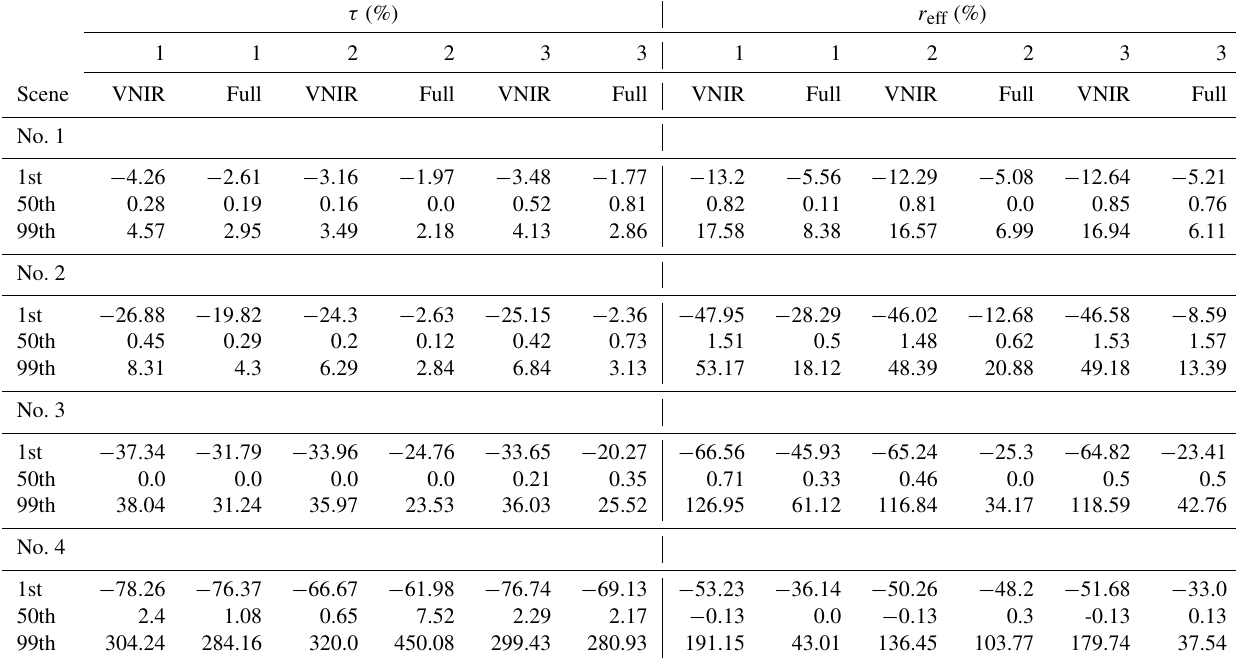
Table 2. Comparison of the cloud property retrieval results from downscaling experiments 1–3, which only account for the VNIR part, and the full downscaling experiments, which include adjustments to both VNIR and SWIR reflectances. The comparison shows the 1st, 50th, and 99th percentiles of the relative differences (cid:49)τ (for the cloud optical thickness τ ) and (cid:49)r eff (for the effective droplet radius r eff ), which illustrate the deviation of the different retrieval approaches from the reference results, normalized by the reference retrievals. Data are from the four example scenes shown in Fig.